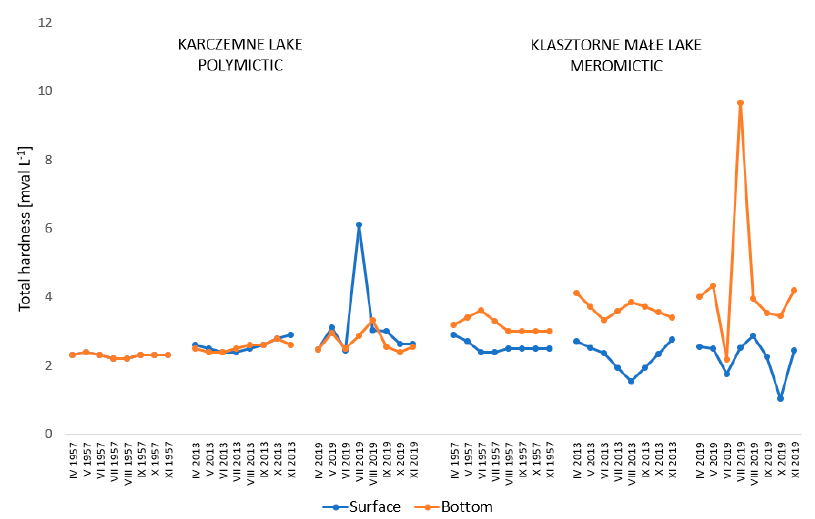
Figure 10. Changes in total hardness values in the water of Karczemne and Klasztorne Małe lakes in selected research years.